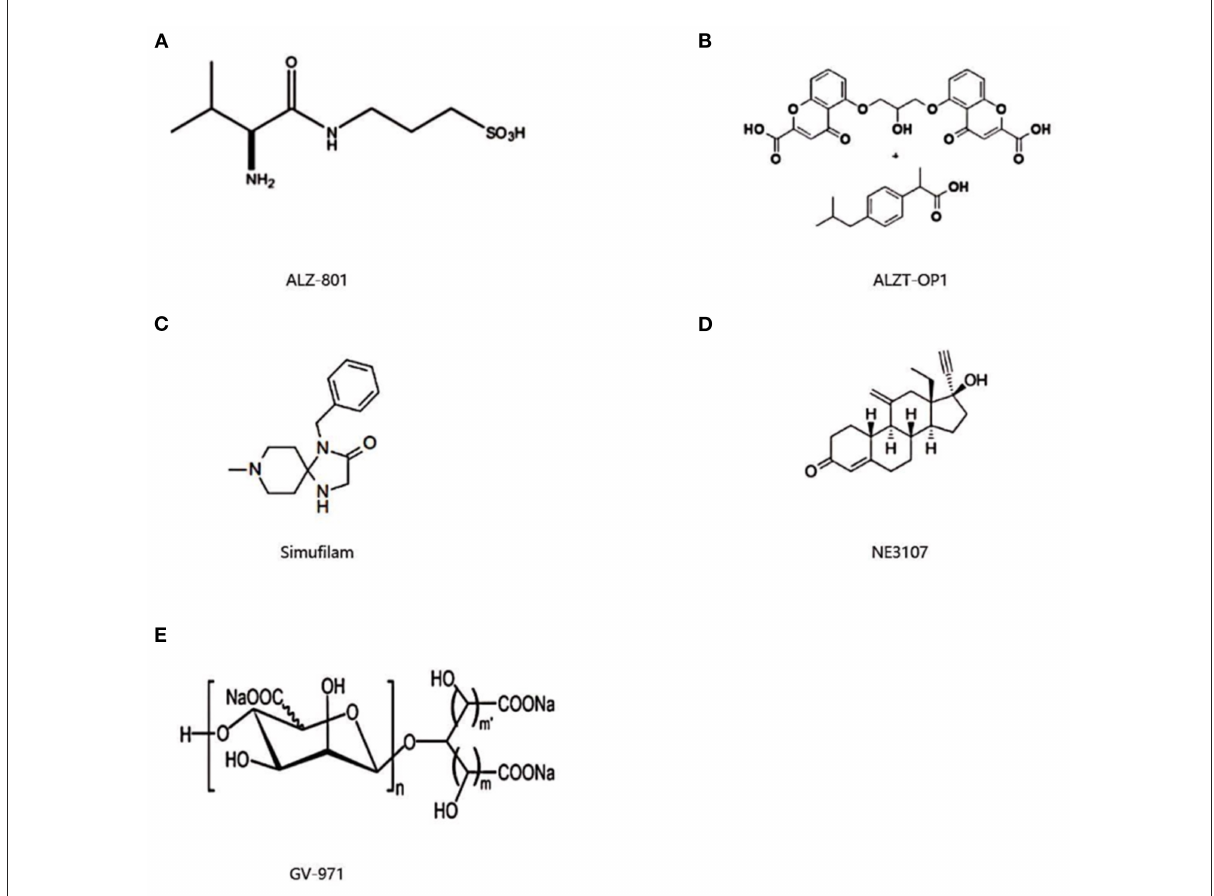
FIGURE2 Chemical structure of ALZ-801 (A) , ALZT-OP1 (B) , simufilam (C) , NE3107 (D) , and GV-971 (E)